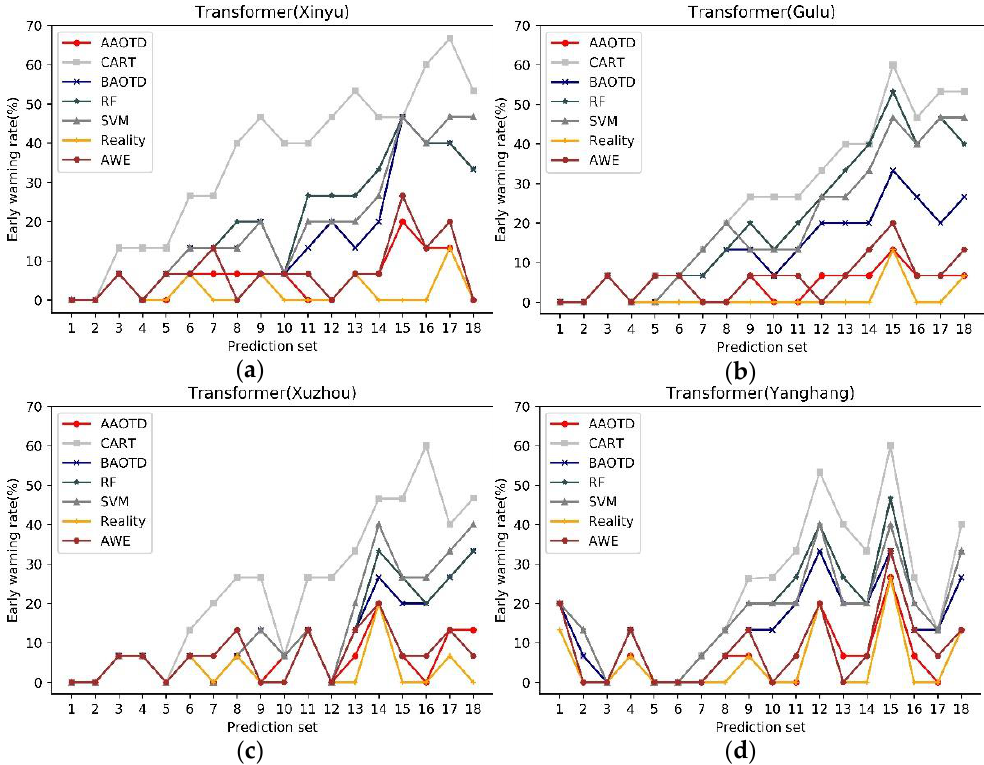
Figure 4. Tendency of abnormal oil temperature warnings from various methods. The 4 subgraphs ( a – d ) show the results of six algorithms for oil temperature prediction of the transformers in 4 different regions (Xinyu, Gulu, Xuzhou, and Yanghang). The x-coordinate represents the serial number of the prediction set, and the y-coordinate represents the early warning rate of the transformer.